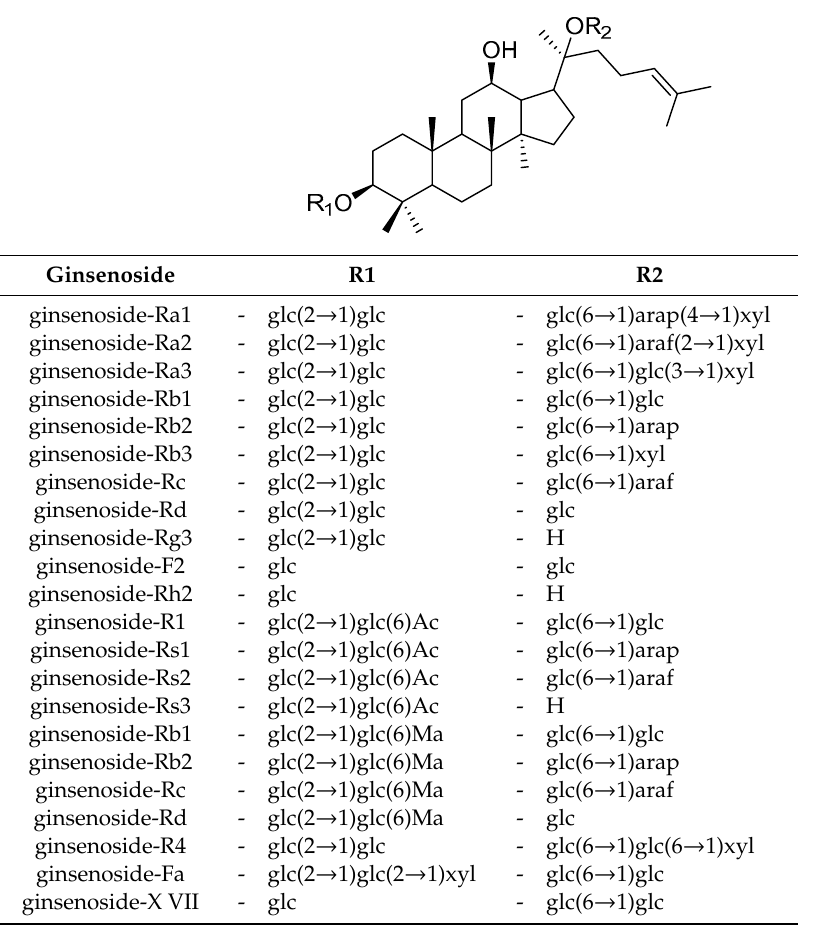
Table 2. Chemical structures of protopanaxadiol saponins.